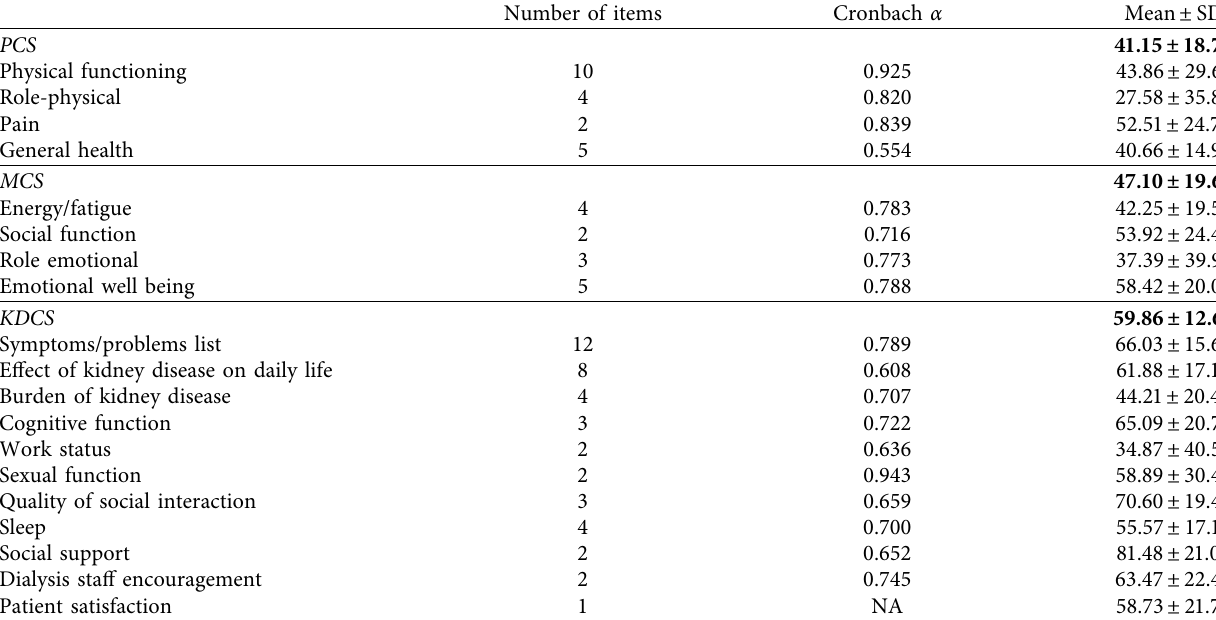
PCS: physical health component summary, MCS: mental health component summary, KDCS: kidney disease component